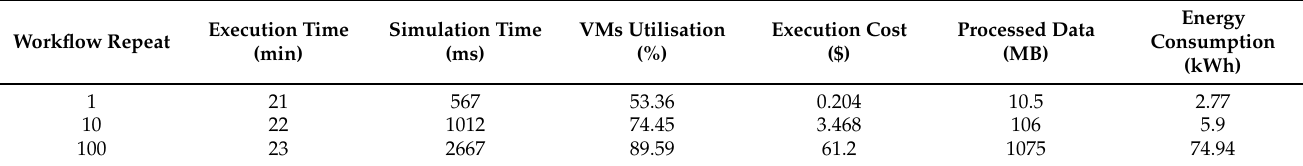
Table 4. The experimental results of DISSECT-CF-Fog with IoT workflow of morning routine scenario in Figure 1.